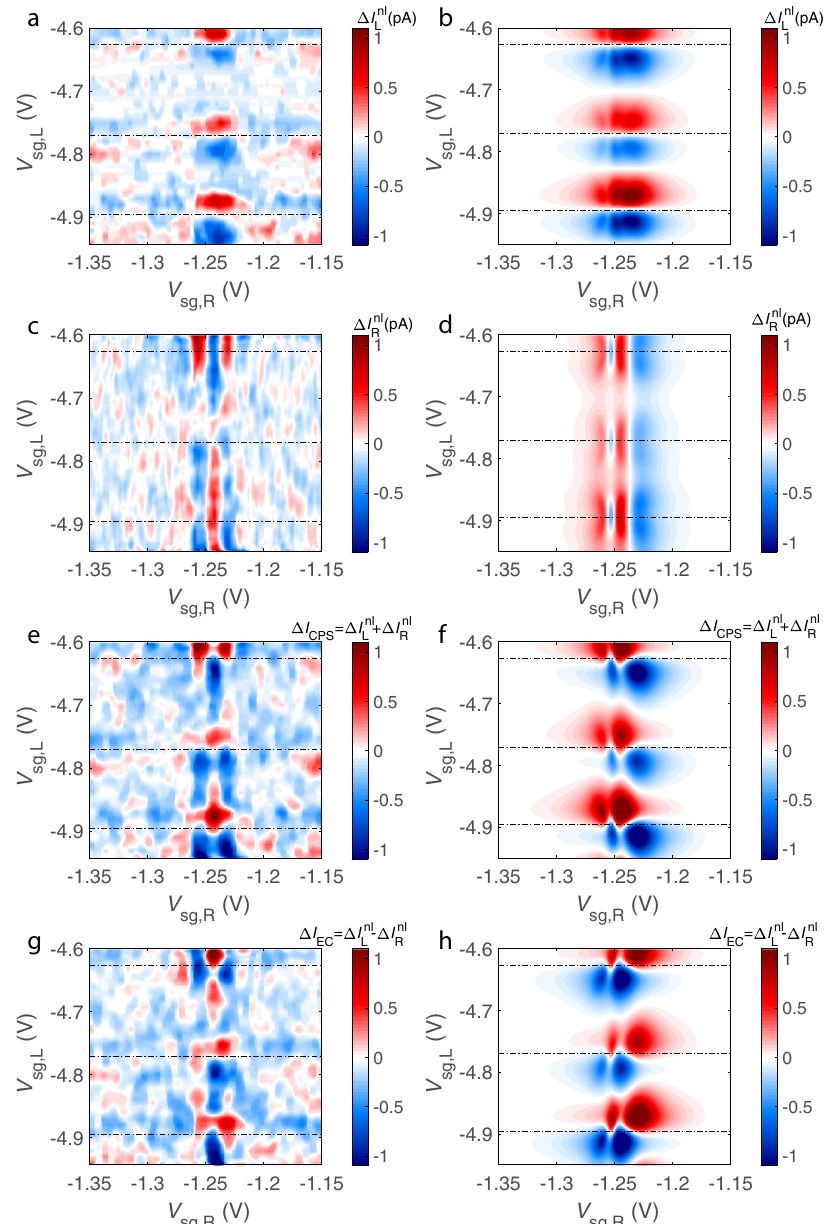
Fig. 3 Interplay of non-local thermoelectric currents in the left and right dots. Non-local contributions to the thermal currents of the right and left dots ( a – d ) and the corresponding CPS and EC currents ( e – h ). The left column (graphs a , c , e , g ) shows the experiment and the right one (graphs b , d , f , h ) — theory. Horizontal dotted lines in the plots indicate the positions of the conductance peak maxima of the left